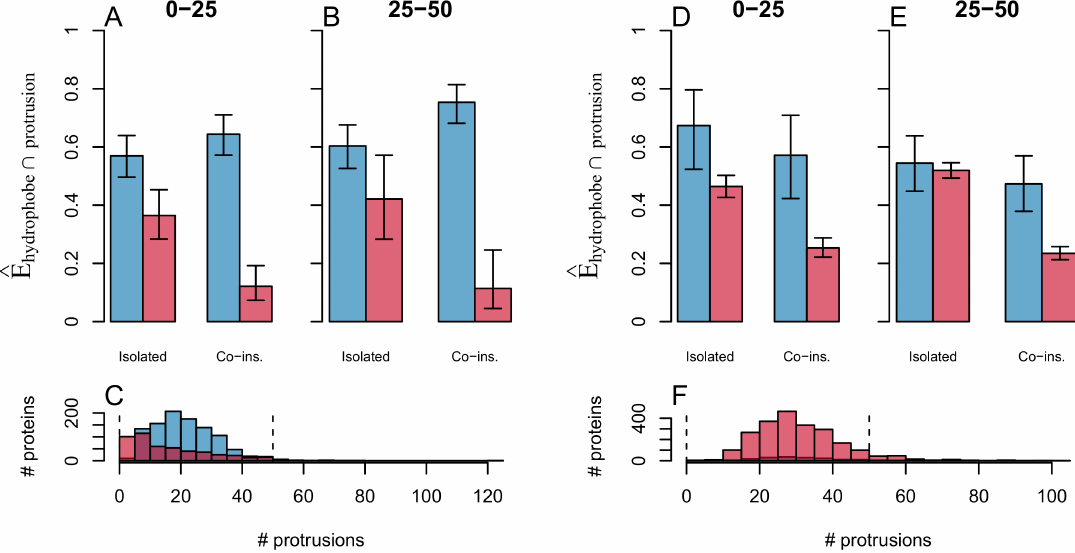
Fig 5. ’Co-insertable protruding hydrophobes’ are common in peripheral proteins and rare in the reference sets. The plots show the occurrence of ‘co-insertable protruding hydrophobes’ on protein surfaces. Panels A-C show the comparison between the sets ‘Peripheral’ and ‘Non-binding surfaces’ and panels D-F the comparison between ‘Peripheral-P’ and ‘Reference Proteins’. Panels A, B, D, and E show the weighted fraction (Eq 5) of proteins that have protruding hydrophobes in the peripheral proteins (blue) and the reference sets (red). We differentiate here between protrusions that have at least one co-insertable protruding hydrophobe (labeled “Co-ins.”), and those that have not (labeled “isolated”). The analysis is done separately for two groups of proteins according to the total number of protrusions on the protein surface ([0, 25 i in panels A and D, [25, 50 i in panels B and E). Panels C and F show the frequency distribution of the total number of protruding residues (“# protrusions”) for all proteins. The selections analysed in panels A, B, D, and E are found between the dashed lines in panels C and F. Error bars in panels A, B, D, and E are 95% confidence